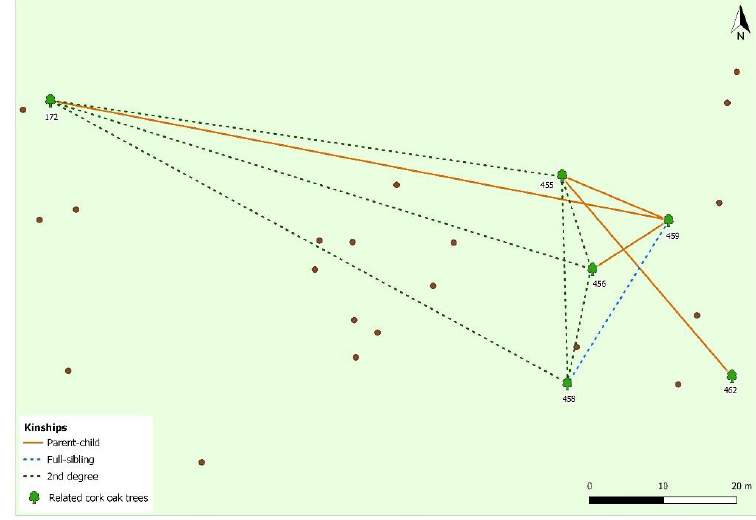
Figure 6. Spatial distribution of the reconstructed pedigree for a cork oak family comprising six individuals. The parent – child, full-sibling and second-degree relationships are illustrated. Finally, a total of four pairs of identical genotype oaks were commonly identified using each IBD matrix. Identical genotype oaks were located very close to each other, ei- ther originating from early sprouts (several decades ago) or multi-seeded acorns resulting from mitotic reproduction of the initial zygote [30 – 32]. Animals such as squirrels could excise the acorns from the soil (or a seed from it) and move them from their original loca- tions to a close spot, explaining the existing distance between each identical genotype oak [33 – 35]. However, when comparing the identical genotypes, which have long been thought to be genetically “identical”, small differences were found ; they were not 100% identical. To our knowledge, this is the first work reporting cork oak trees with almost